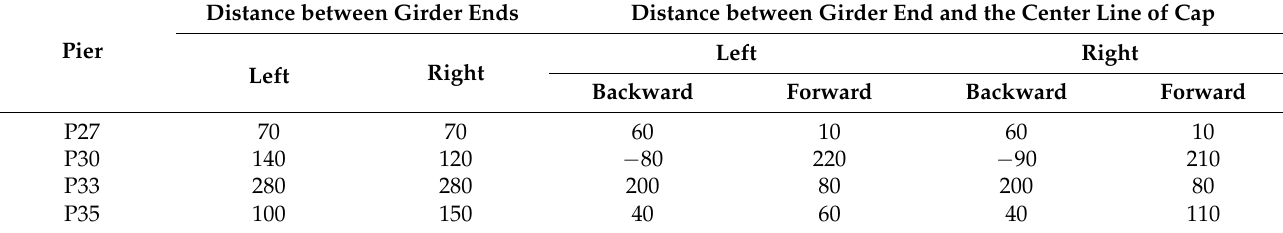
Table 2. Distance between girder ends (mm).